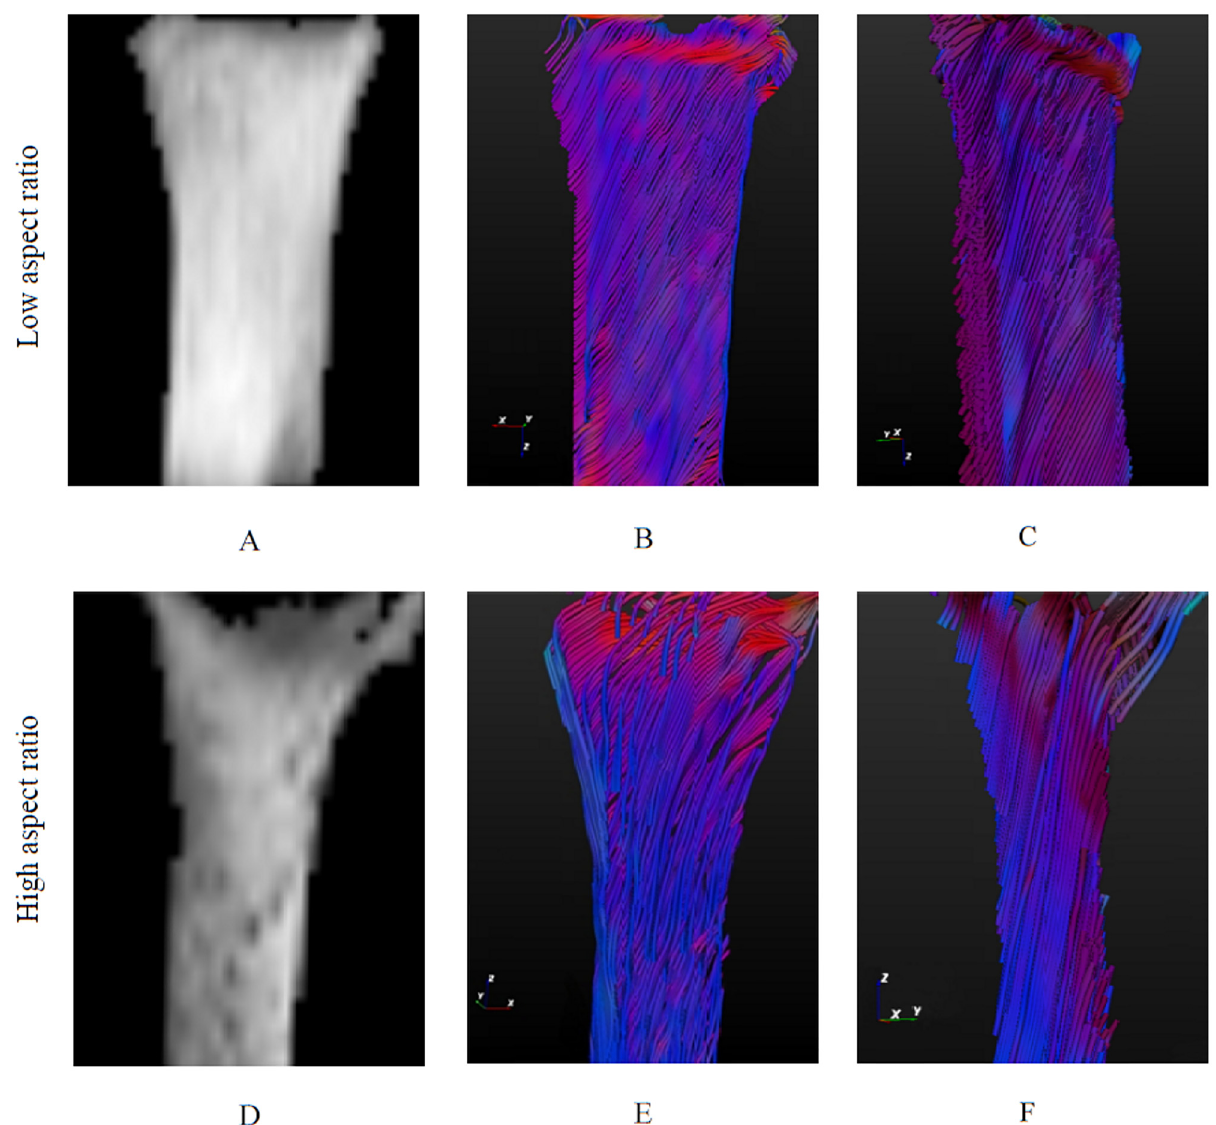
Fig 7. T 2 -weighted DTI images of low (A) and high (D) aspect ratio TE strips after 3 weeks of culture. Fiber tracts represent the fibrous structure in the engineered constructs with low (top view (B), side view (C)) and high (top view (D), side view (F)) aspect ratio. Fibers are color-coded based on their directions: red (x direction), green (y direction) and blue (z direction). Collagen fibers are mostly aligned in the constrained direction in high aspect ratio strips and in the oblique direction in low aspect ratio strips. Strip size in image (A-C): 10×5×1 mm, and in image (D-F): 10×3×1 mm.